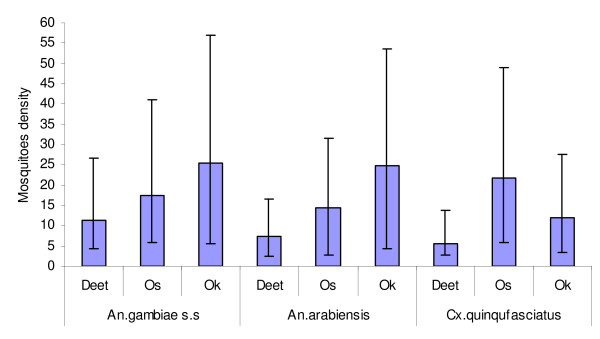
Biting success exhibited by three mosquito species treatments into twenty percent concentration of DEET, OK and OS.